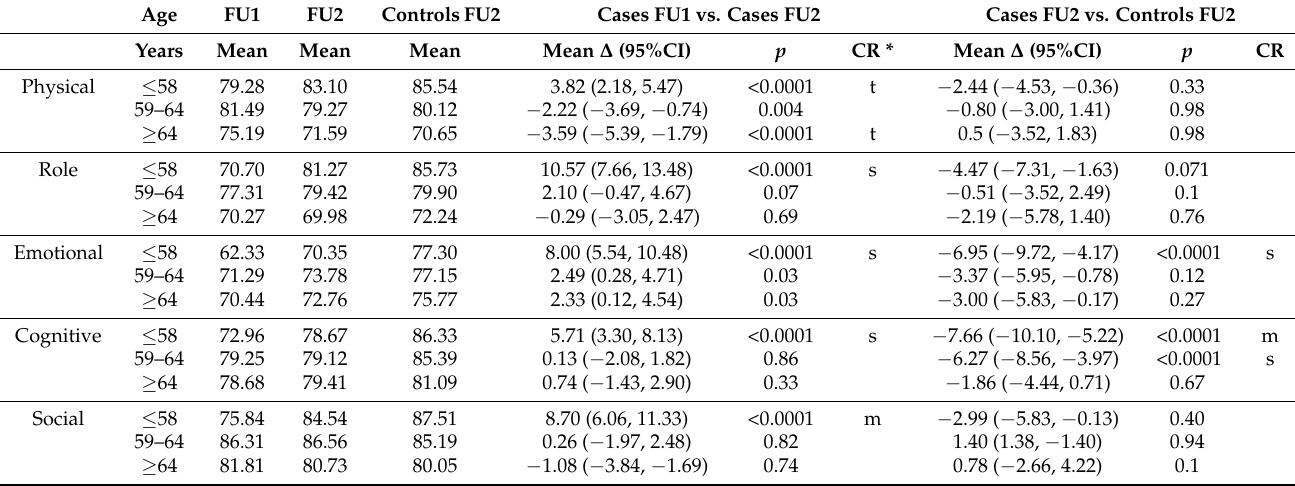
Table 3. Functioning of breast cancer survivors at FU1 and FU2 stratified by age and compared to healthy controls at FU2. Age Cases FU1 vs. Cases FU2 Cases FU2 vs. Controls